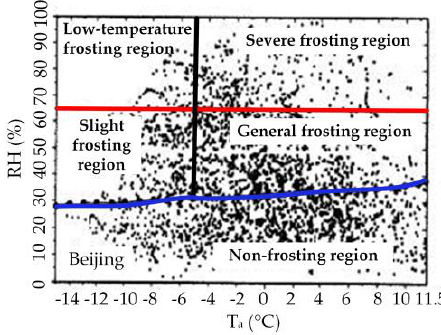
Figure 12. Distribution of air parameters during heating season in Beijing [74].